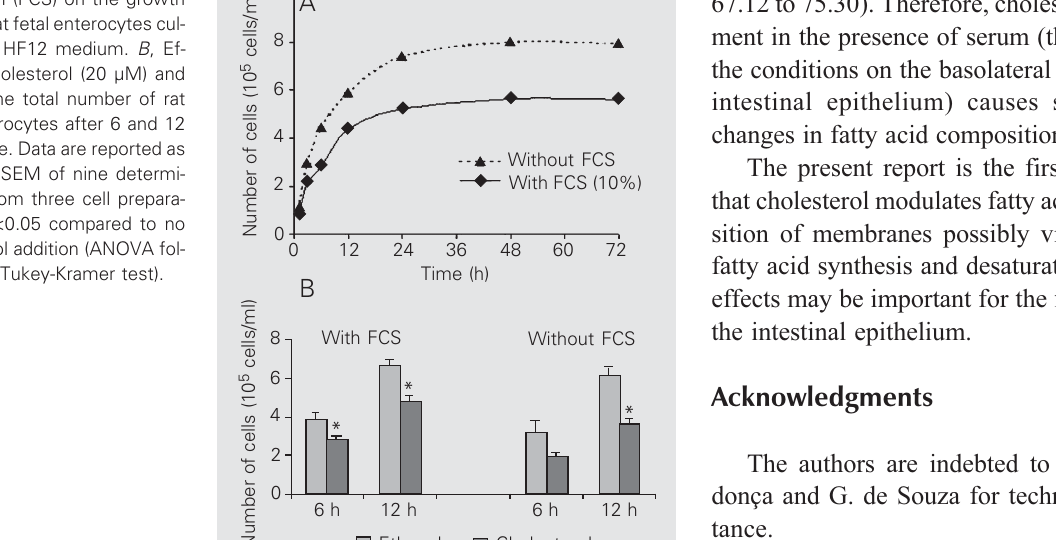
Figure 1. A , Effect of 10% fetal calf serum (FCS) on the growth curve of rat fetal enterocytes cul- tivated in HF12 medium. B , Ef- fect of cholesterol (20 µM) and FCS on the total number of rat fetal enterocytes after 6 and 12 h in culture. Data are reported as means ± SEM of nine determi- nations from three cell prepara- tions. *P<0.05 compared to no cholesterol addition (ANOVA fol- lowed by Tukey-Kramer